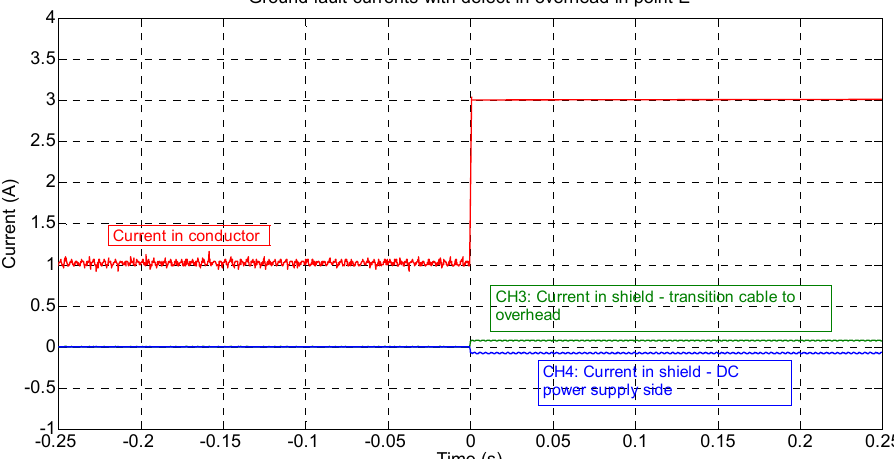
Figure 14. Ground fault currents with external ground fault in overhead line side in E with 1 A load current.